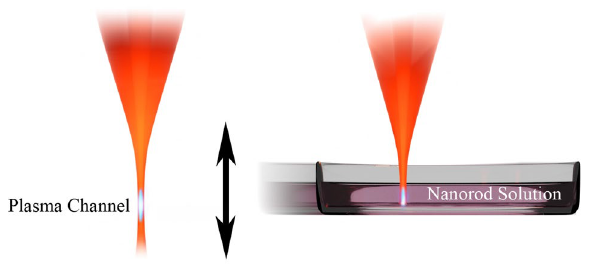
Figure 1. An illustration of the experimental setup for the femtosecond laser irradiation, where the laser is focused vertically as shown in orange. The drawing on the left shows the plasma channel (in bright blue) formed in the air and the drawing on the right shows the surface of the nanorod solution is placed above the air plasma channel position. The cuvette can move vertically with a translation stage to vary the laser spot size on the surface of the